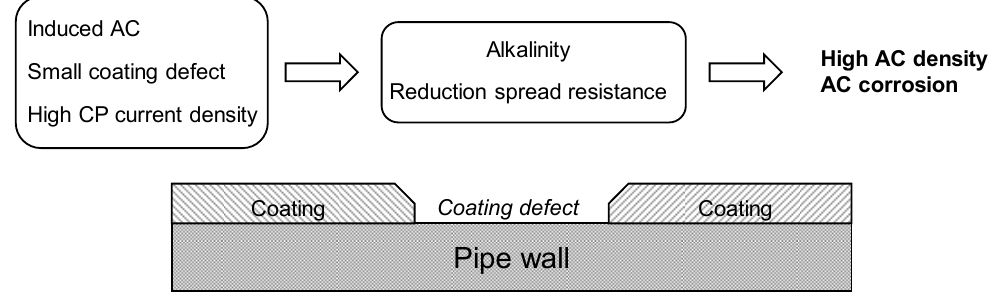
Figure 12. Schematic representation of the AC corrosion mechanism of carbon steel under CP condition, as proposed by Nielsen et al. [63 – 66].